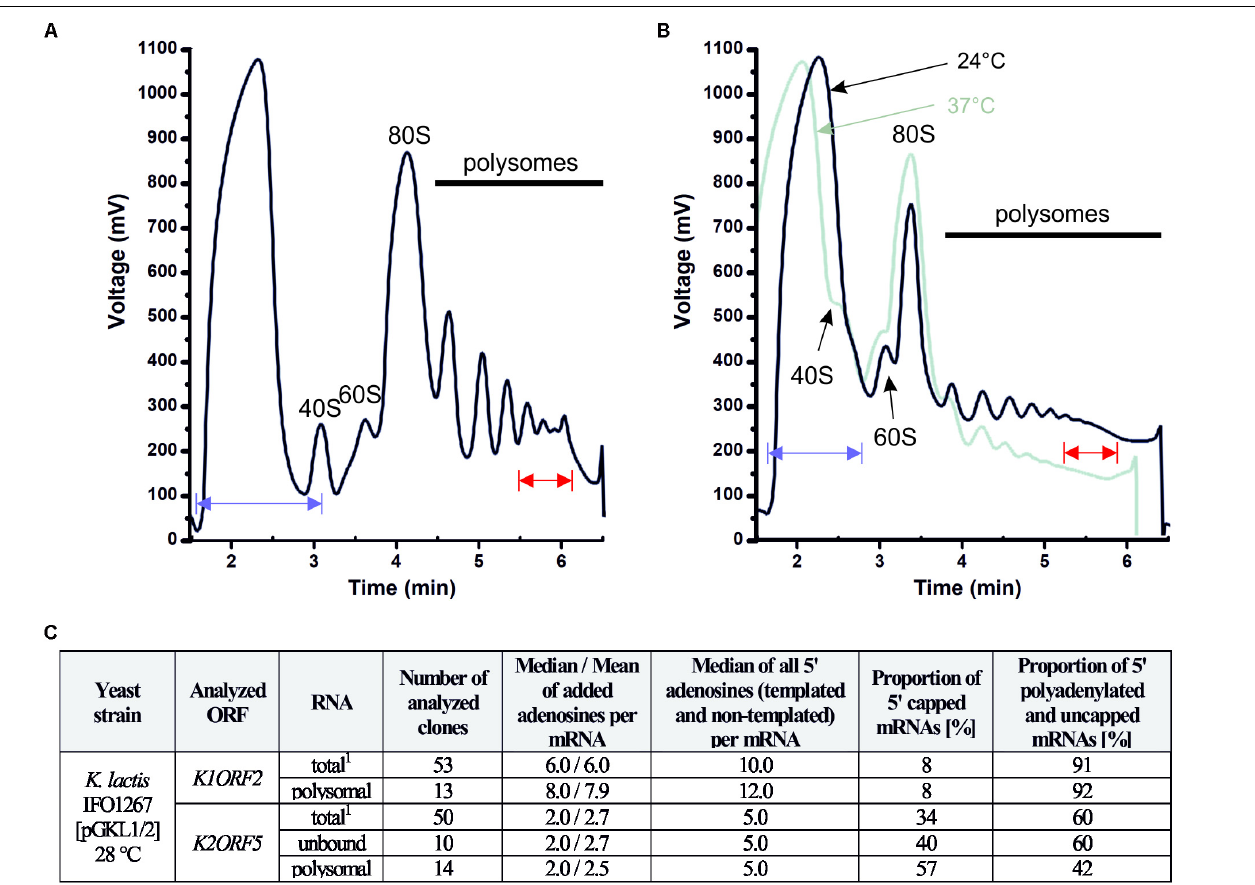
FIGURE 11 | The 5 (cid:48) polyadenylated and uncapped pGKL mRNAs are loaded onto yeast high polysomes. (A) Analysis of polysomes from K. lactis IFO1267 grown exponentially in YPD medium at 28 ◦ C. The fraction of high polysomes (depicted in red) and the non-polysomal fraction (unbound, depicted in blue) were used for the mRNA purification and 5 (cid:48) RACE analysis of pGKL mRNAs. (B) Analysis of polysomes from the S. cerevisiae CWO4 cdc33-42 ρ 0 [pGKL1/2] strain grown in YPD medium in parallel at permissive (24 ◦ C, black curve) and restrictive (37 ◦ C, green curve) temperatures. Overall cellular translation was substantially decreased in the absence of functional eIF4E (green curve). The fractions of high polysomes (depicted in red) and non-polysomal fractions (depicted in blue) from cultures grown at the permissive (24 ◦ C) and non-permissive (37 ◦ C) temperatures were used for the total RNA purification and 5 (cid:48) RACE analysis of pGKL mRNAs ( Figures 12 , 13 ). (C) Tabular summary of the 5 (cid:48) RACE results from mRNAs purified from unbound and high polysome fractions in the experiment “A”. Messenger RNAs of each ORF subjected to 5 (cid:48) RACE analysis are characterized by the following data: (1) ORF name; (2) source of purified mRNA; (3) total number of analyzed clones; (4) median and mean of 5 (cid:48) added adenosines per mRNA molecule; (5) median of all 5 (cid:48) adenosines (templated and non-templated) per mRNA molecule; (6) proportion of 5 (cid:48) capped mRNAs [in %]; (7) proportion of 5 (cid:48) polyadenylated and uncapped mRNAs [in %]. 40S, eukaryotic small ribosomal subunit; 60S, eukaryotic large ribosomal subunit; 80S, eukaryotic ribosome